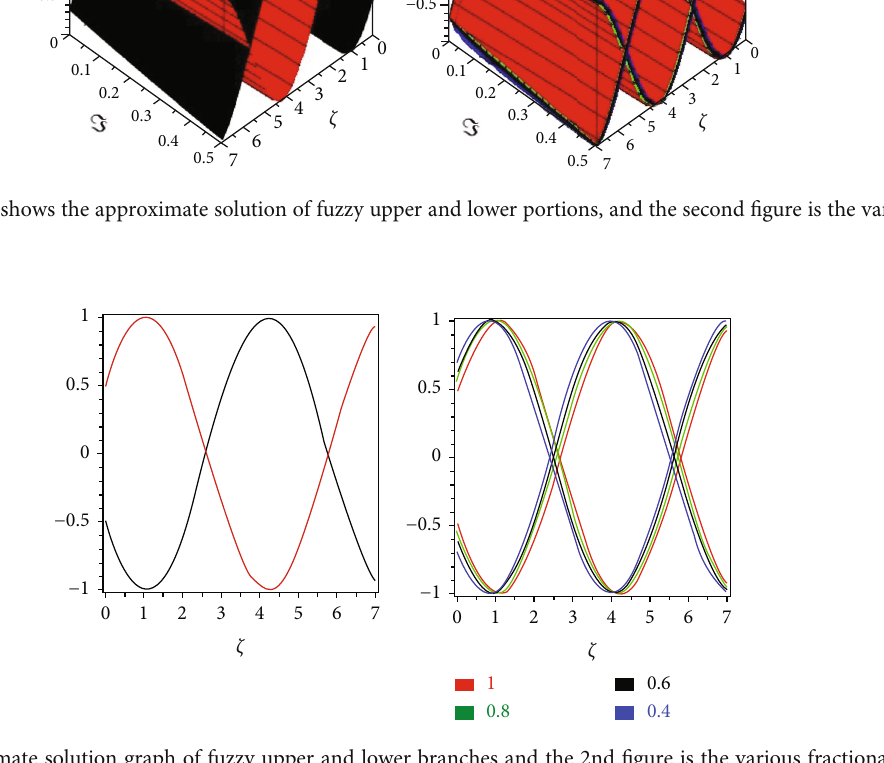
Figure 2: The approximate solution graph of fuzzy upper and lower branches and the 2nd fi gure is the various fractional order of ℘ .